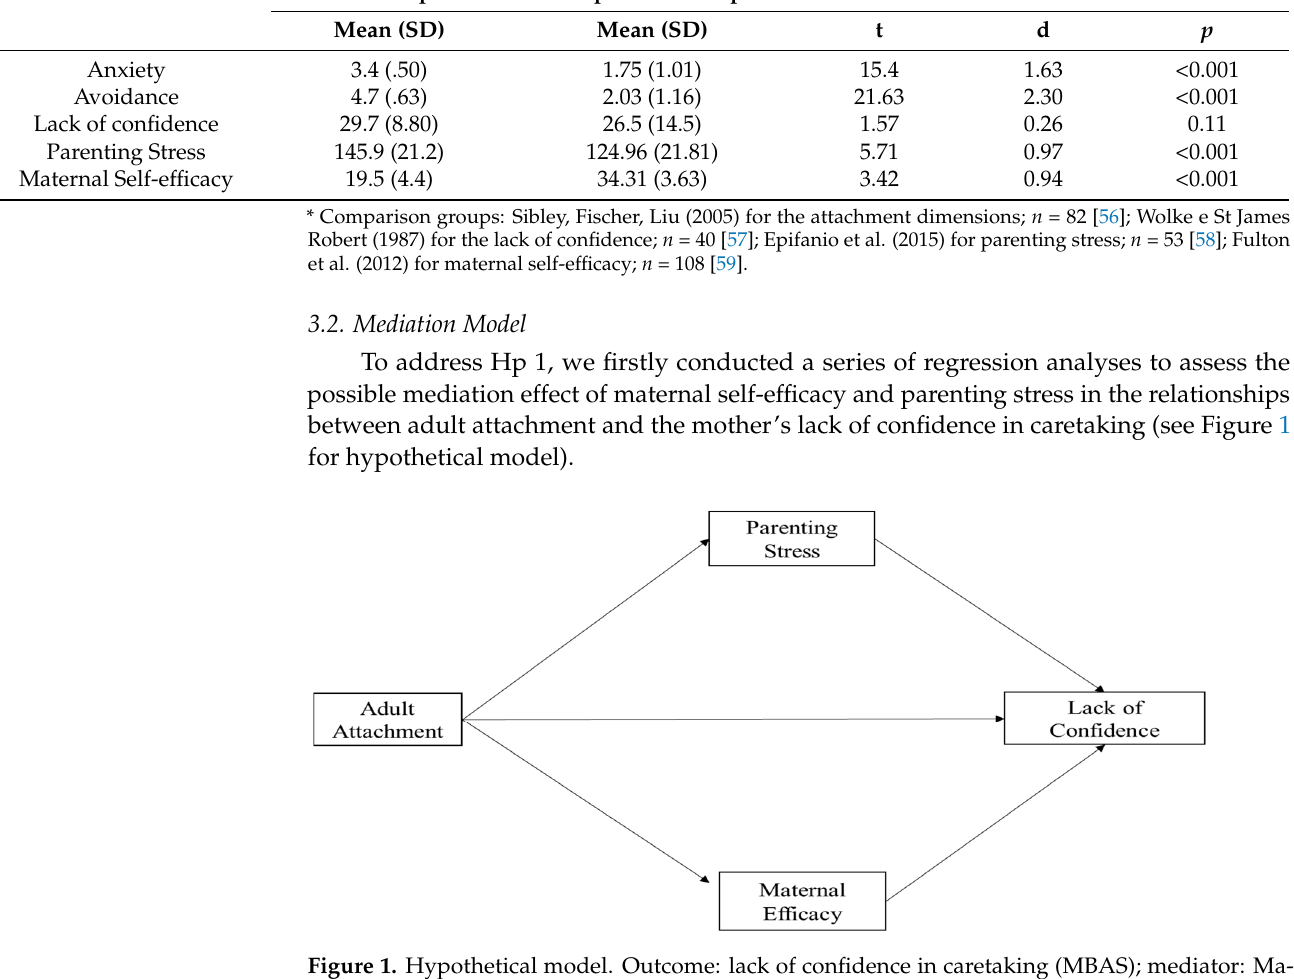
Figure 1. Hypothetical model. Outcome: lack of confidence in caretaking (MBAS); mediator: Maternal Self-Efficacy (MEQ) and Parenting Stress (PSI-SF); predictor: Adult Attachment-Anxiety and Avoidance Dimensions (ECR-R).